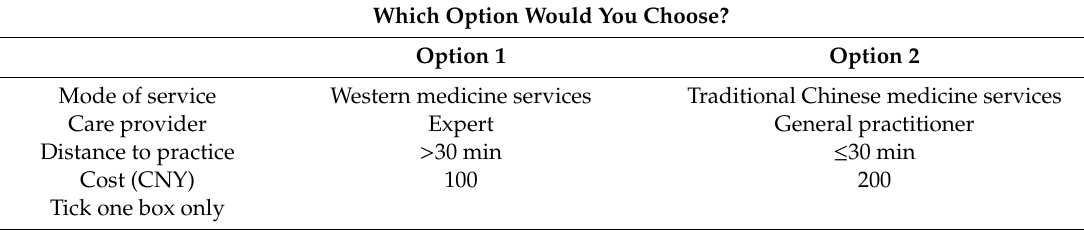
Table 2. Example of a choice